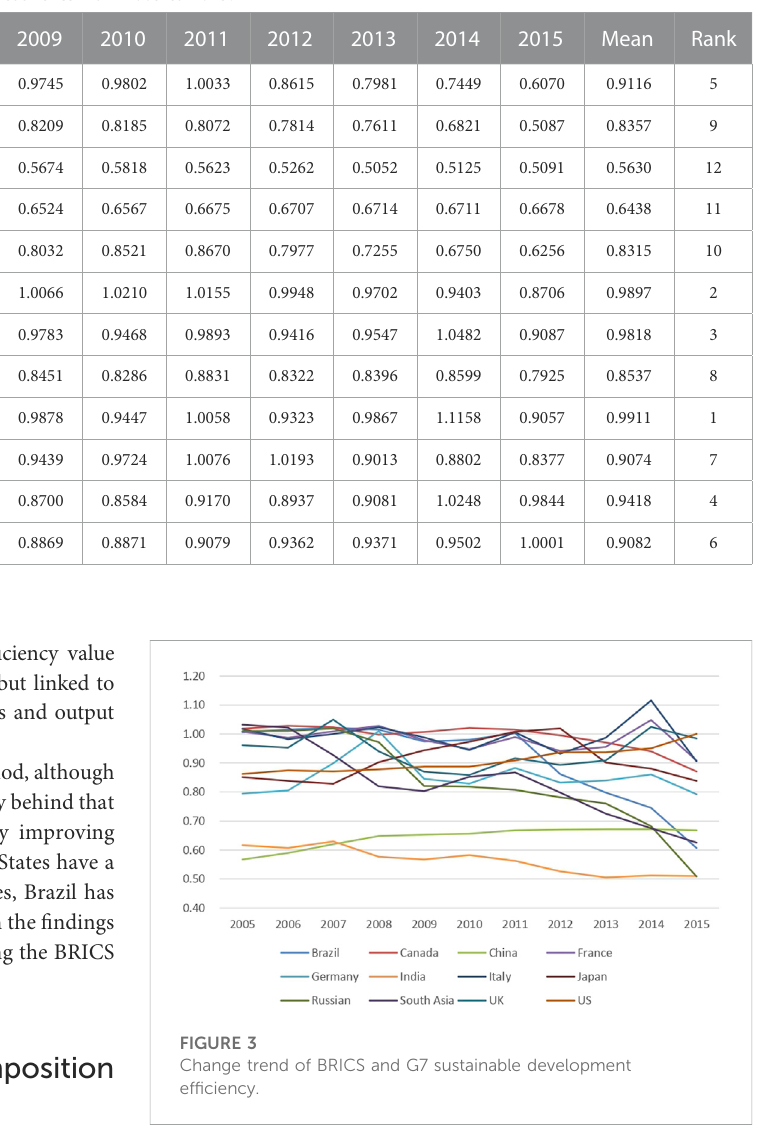
TABLE 3 Sustainable development ef fi ciency of BRICS and G7 countries from 2005 to 2015. Country